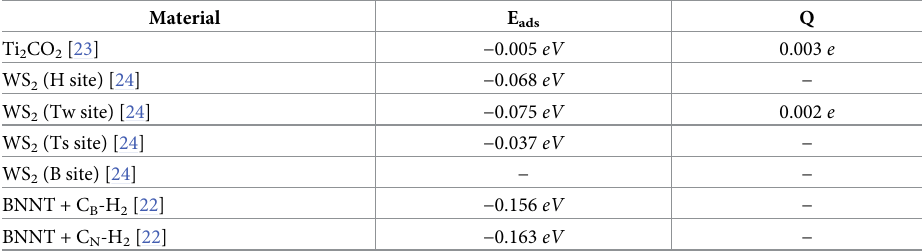
Table 2. The adsorption energies and charge transfer from H 2 gas molecule to different materials.